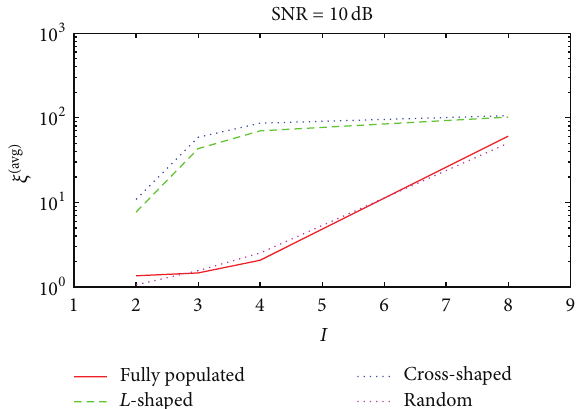
Figure 9: Array geometries comparison—( 𝑁 = {9, 25} ; 𝑑 𝑥 = 𝑑 𝑦 = 0.5𝜆 ; 𝐼 ∈ [2 : 8] ; SNR = 10dB; 𝑇 = 1 ; 𝐶 = 50 )—behavior of the location index 𝜉 ( ave ) averaged among 𝐶 different noisy scenarios versus the number of arriving signals 𝐼 when using the